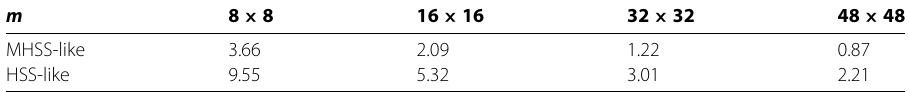
Table 1 The optimal parameters α for MHSS-like and MHSS-like methods m 8 × 8 16 × 16 32 × 32 48 × 48 MHSS-like 3.66 2.09 1.22 0.87 HSS-like 9.55 5.32 3.01 2.21